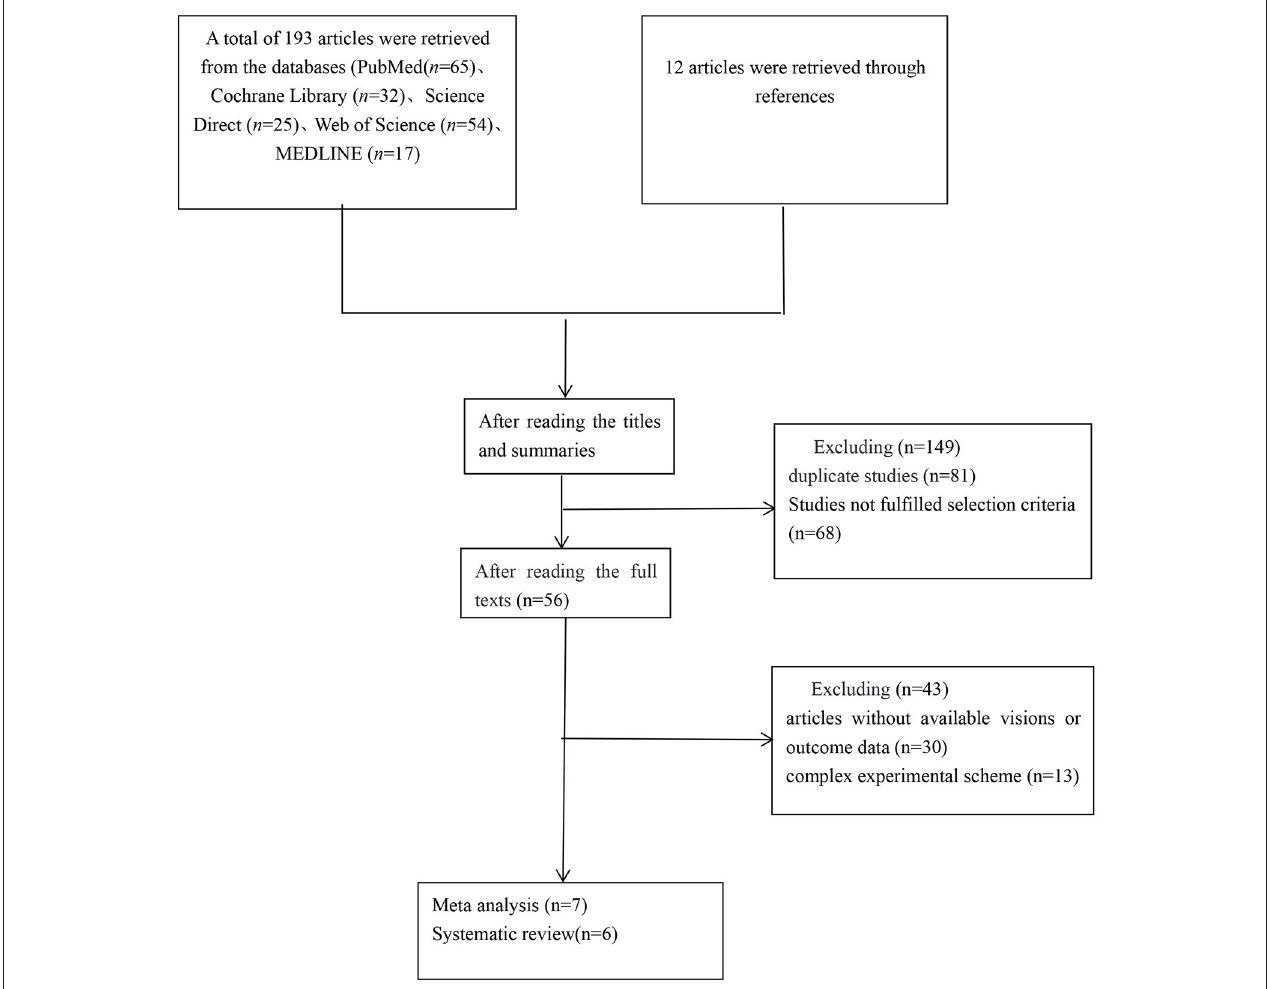
FIGURE 1 | Flow chart of study